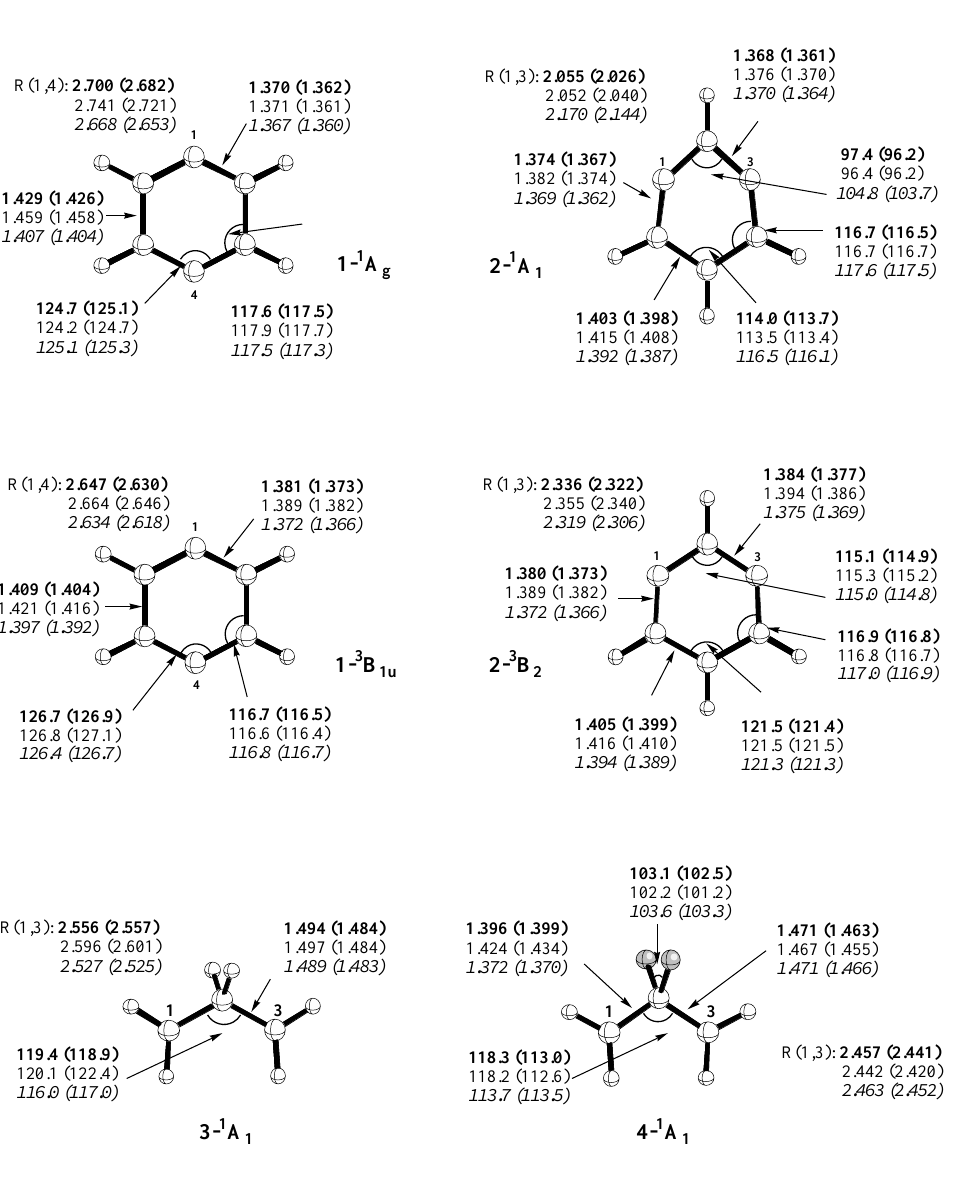
Figure 5: Parts a and b. For caption, see next